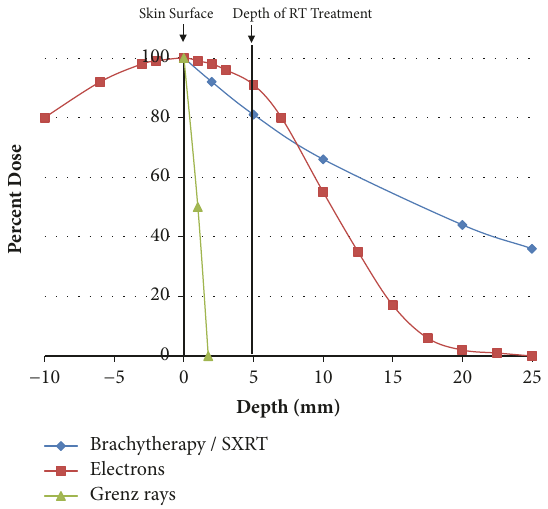
therapy is on the Y axis. Brachytherapy and superficial radiotherapy give good dose to skin surface and at 5 mm but do give significant dose to dermis which may lead to increased late effects, for example, fibrosis, telangiectasia in the future. Electrons do give a good drop- off in dose so there is less dose to